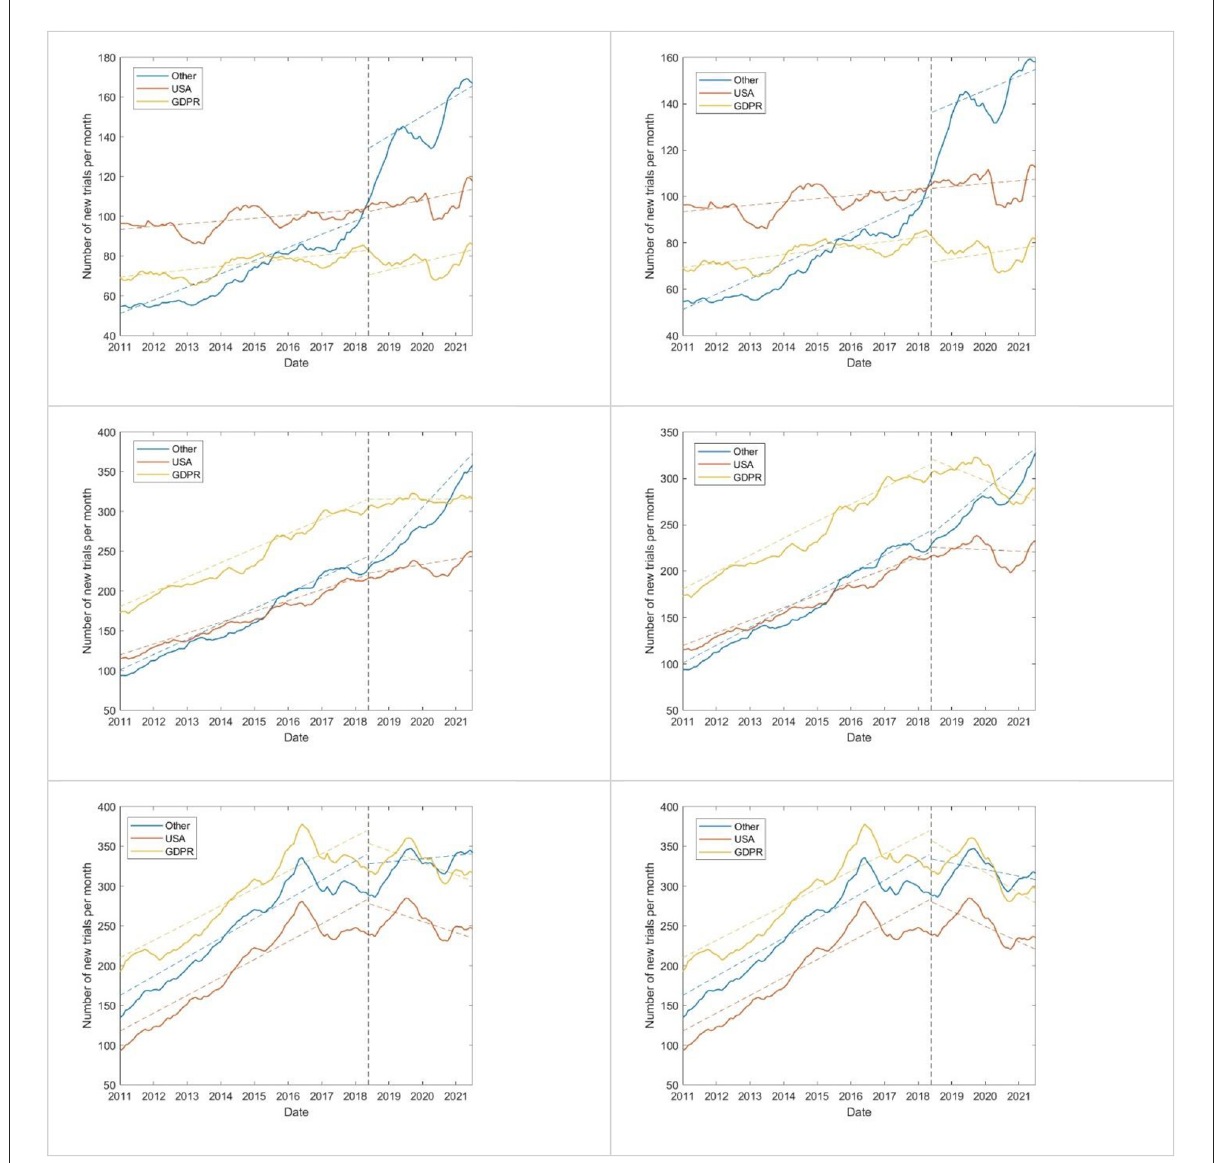
FIGURE2 Number of new phase 1 (top) , 2 (center) , and 3 (bottom) clinical trials registered on ICTRP per month by DPI status. Graphs on the left comprise all trials, while those on the right exclude COVID-19 trials. The vertical dotted line denotes the date of DPI. Colored dotted lines are linear regression lines fit to the